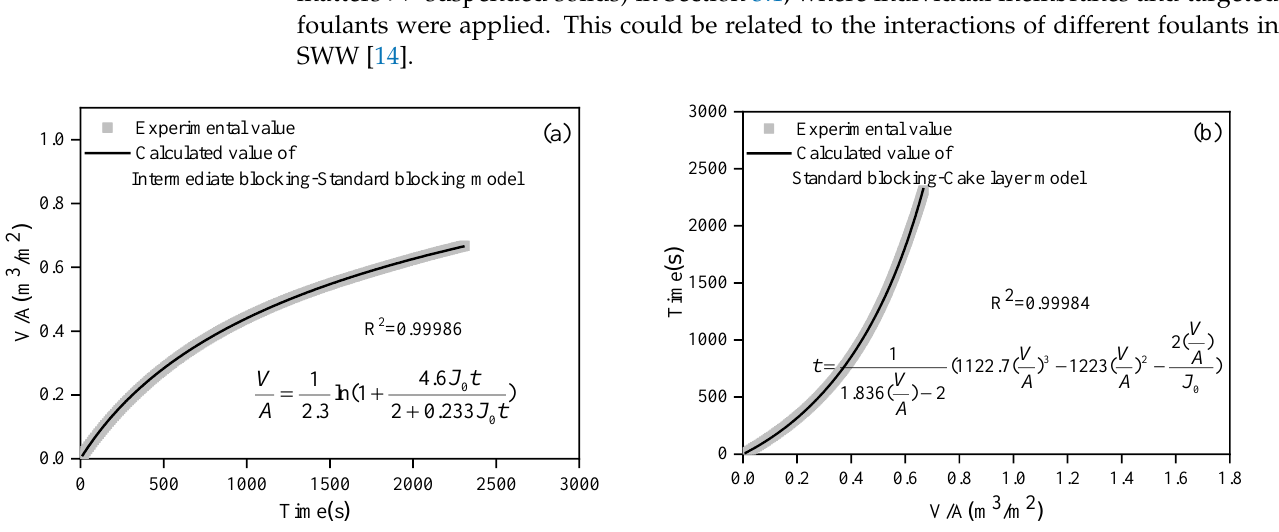
Figure 8. Nonlinear fitting of the combined models of intermediate blocking – standard blocking ( a ) and standard blocking – cake layer ( b ) for the MF process during the gradient filtration of low-concentration SWW. Table 3. Fitting results of combined models during gradient filtration of SWW.